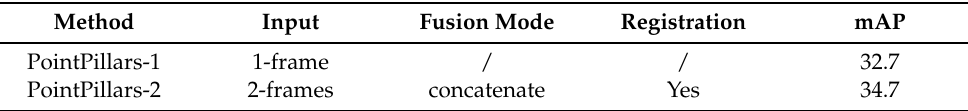
Table 1. Comparison between using 1 frame and 2 frames.